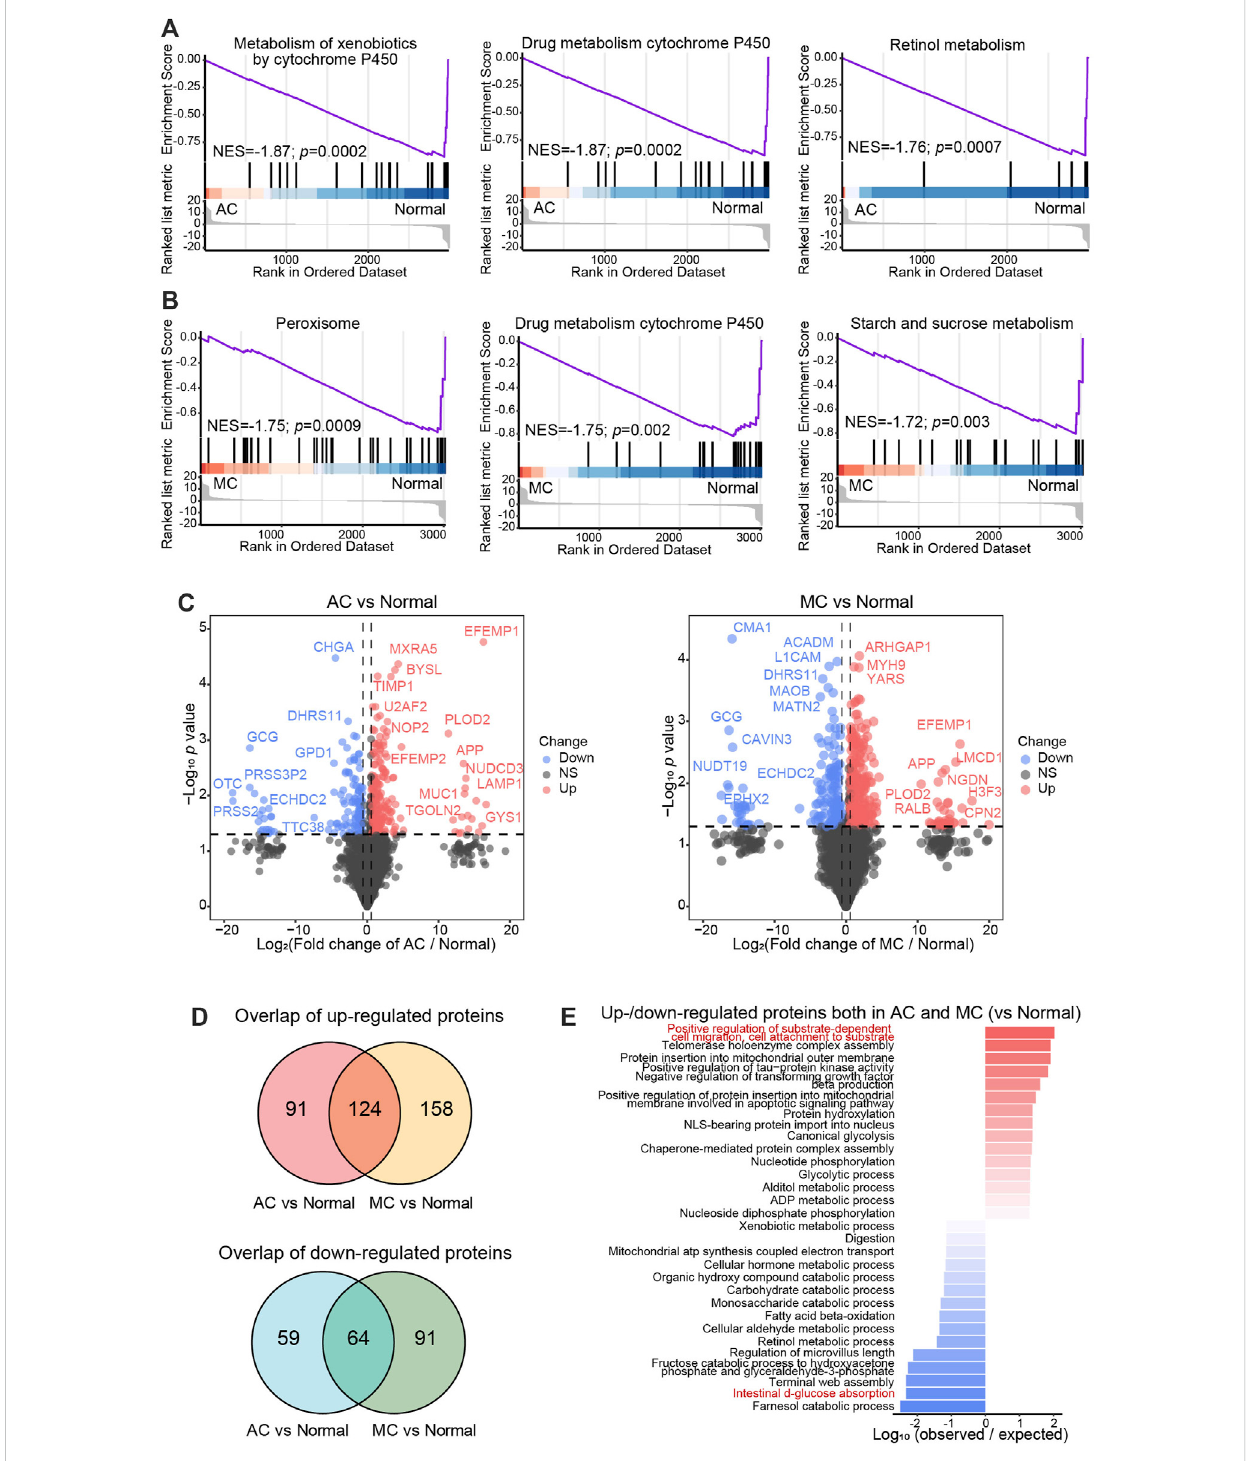
Common proteomics characteristics between two types of colorectal adenocarcinomas and normal colon. A – B: Gene set enrichment analysis (GSEA) showed the top three signi fi cantly enriched hallmarks between AC and normal tissue (A) , and MC and normal tissue (B) . NES: normal enrichment score. (C) Volcano plots showed the differentially expressed proteins between AC and normal tissue (left), and MC and normal tissue (right). Cutoff: fold change > 1.5, p < 0.05. (D) Venn diagrams exhibited the overlap up- (upper) or down- (lower) regulated differentially expressed protein numbers between AC and normal tissue, and MC and normal tissue. (E) Bar plot showed the top -15 biological processes enriched with the overlap up- or downregulated differentially expressed proteins according to log 10 (observed/expected